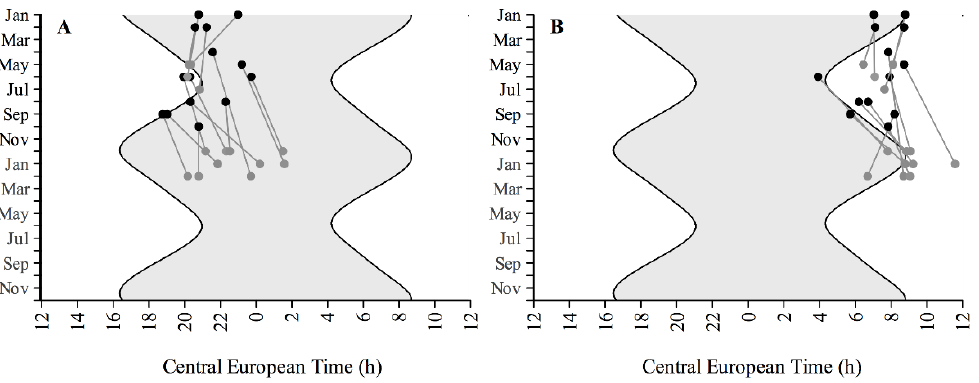
Figure 3. Timing of the melatonin rhythms. Individual raw measurements of ( A ) dim light melatonin onset; and ( B ) dim light melatonin offset before (black circles) and after (grey circles) cataract surgery across the year as a function of Central European Time (CET). The grey area represents the nights.